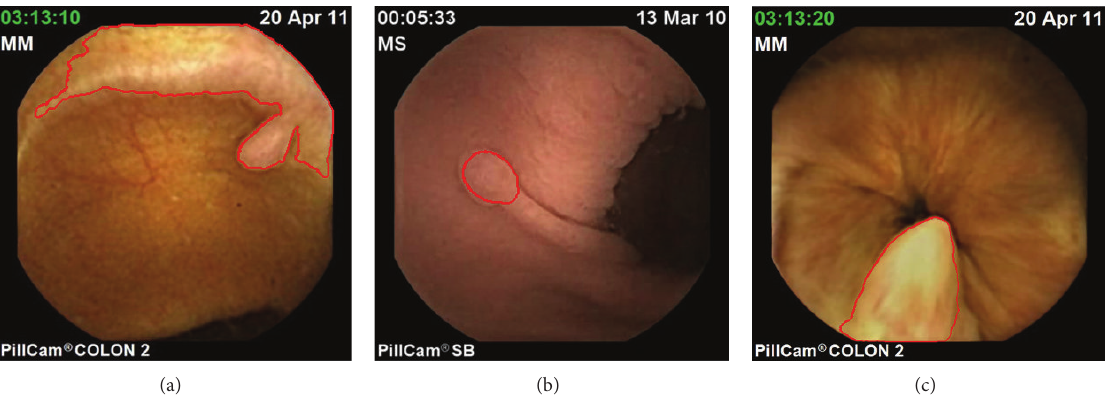
Figure 10: WCE image segmentation using histogram-based active contour approach with KL divergence. (a) Colon sigmoid polyp, (b) gastric polyps in Peutz-Jeghers syndrome, and (c) hypertrophied anal papilla. The same initialisation and hyper parameters were chosen as in the previous experiments.